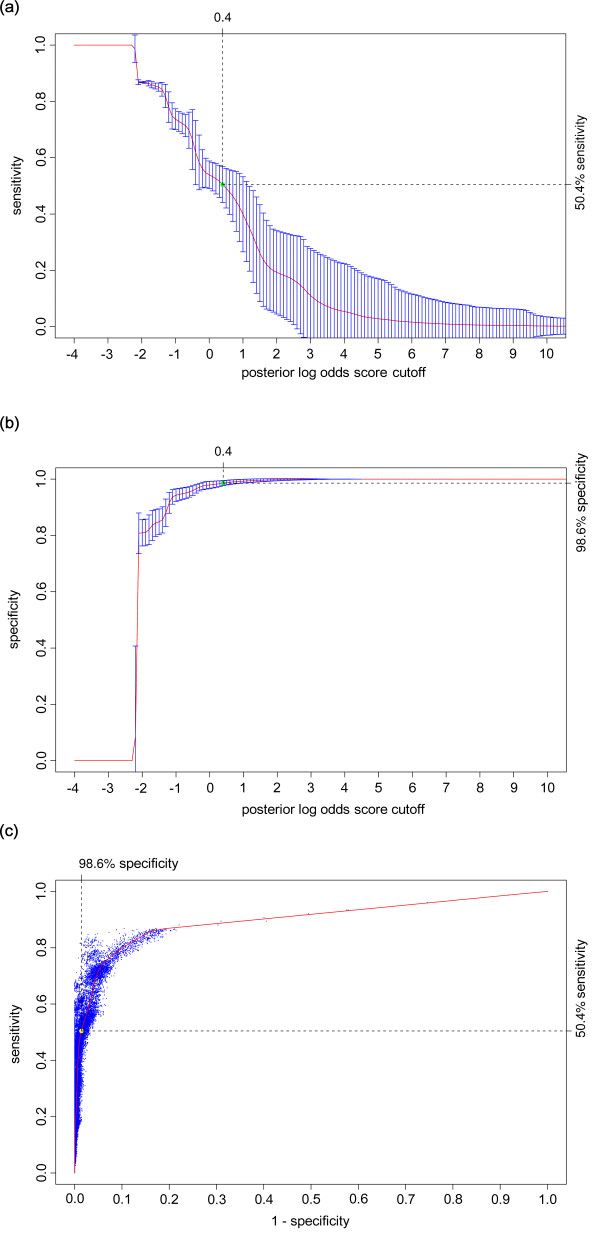
Estimation of prediction accuracy. The accuracy of predictions was estimated from 1,000 runs of 10-fold cross-validations using 1,000 alternative training sets (see Materials and methods). The threshold/working point used for the final predictions of new nucleolar proteins is marked in each plot. (a) The sensitivity (SE = TP/(TP + FN)) of our classifier is plotted over different thresholds of classifier scores (log posterior odds ratios) applied to each cross-validation run. The logarithmic posterior odds ratios indicate how likely it is under the naïve Bayesian model that a protein is an NRCA protein (positive scores) versus that it is not an NRCA protein (negative scores). A single point on the line and its error bar stems from calculations of the average sensitivity and its standard deviation obtained from 1,000 cross-validation runs using a distinct classification score threshold. Confidence intervals are ± 2-fold standard deviation intervals around the mean. Note that at the threshold that was finally used for prediction (0.4) we expect to reach a sensitivity of 50.4%. This means that we have probably still missed as many NRCA proteins as we have predicted (62). (b) The specificity (SP = TN/(TN + FP)) of our classifier is plotted over different thresholds of classifier thresholds (log posterior odds ratios) that were applied on results of each of 1,000 cross-validation runs. Confidence intervals are ± 2-fold standard deviation intervals around the mean. Note that at the finally used threshold of 0.4 the specificity reaches 0.986, meaning that we expect only 1.4% of false positives among our predictions. (c) The ROC curve of our classifier is plotted as sensitivity versus (1-specificity). Each individual data point reflects predictions at a single cross-validation run when a single prediction threshold is applied. The central line is based on averaged SE/SP values for each threshold applied. The ROC curve gives an impression of the quality of a classifier. It is a general indicator of classification performance. The bigger the AUC, the better the classifier. We obtained an AUC value of 0.98, which generally indicates a classification of high quality. The ROC curve was also the basis for the selection of our final classifier threshold, as it illustrates the trade-off between sensitivity and specificity. We chose to be very conservative (high specificity) for the sake of missing true NRCA proteins (lower sensitivity).